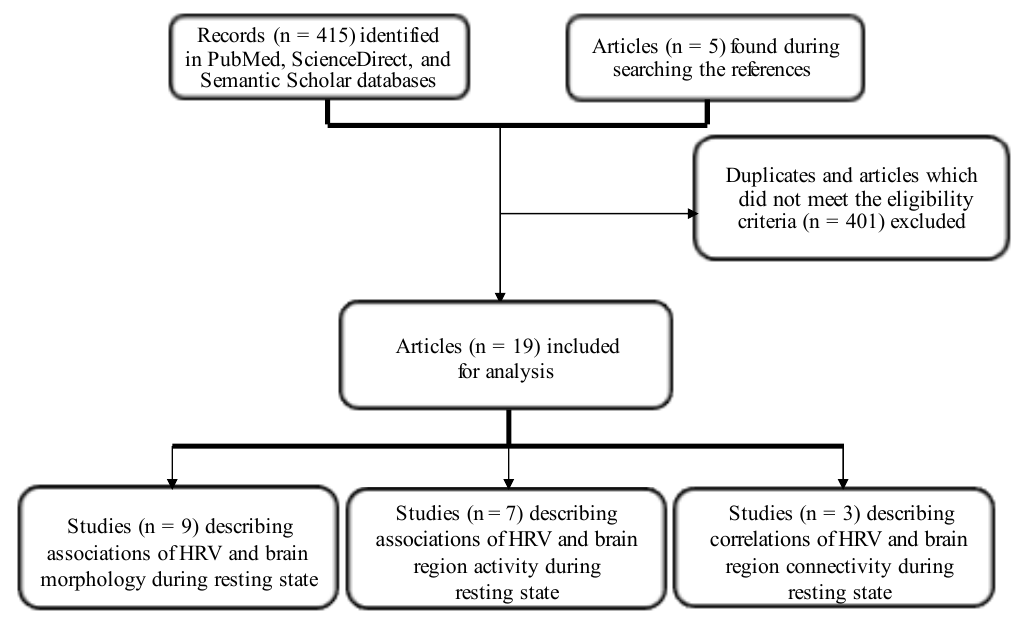
Figure 2. Flow chart of systematic review of studies on neural correlates of heart rate variability during the resting state. Abbreviations: HRV — heart rate variability.